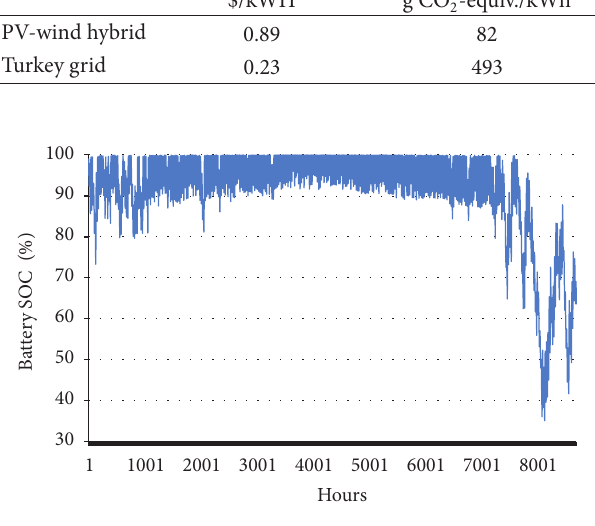
Figure 10: Measured results of